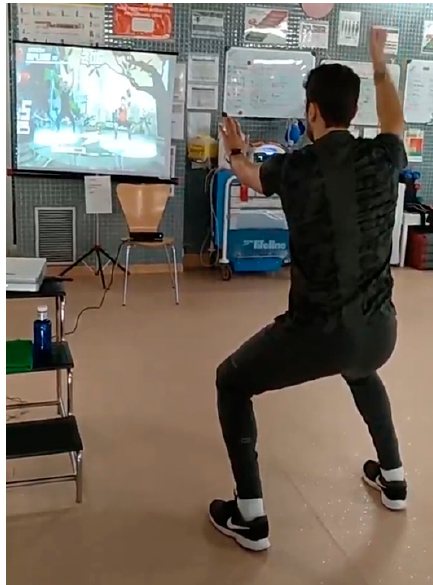
Figure 1. Patient performing the experimental protocol.